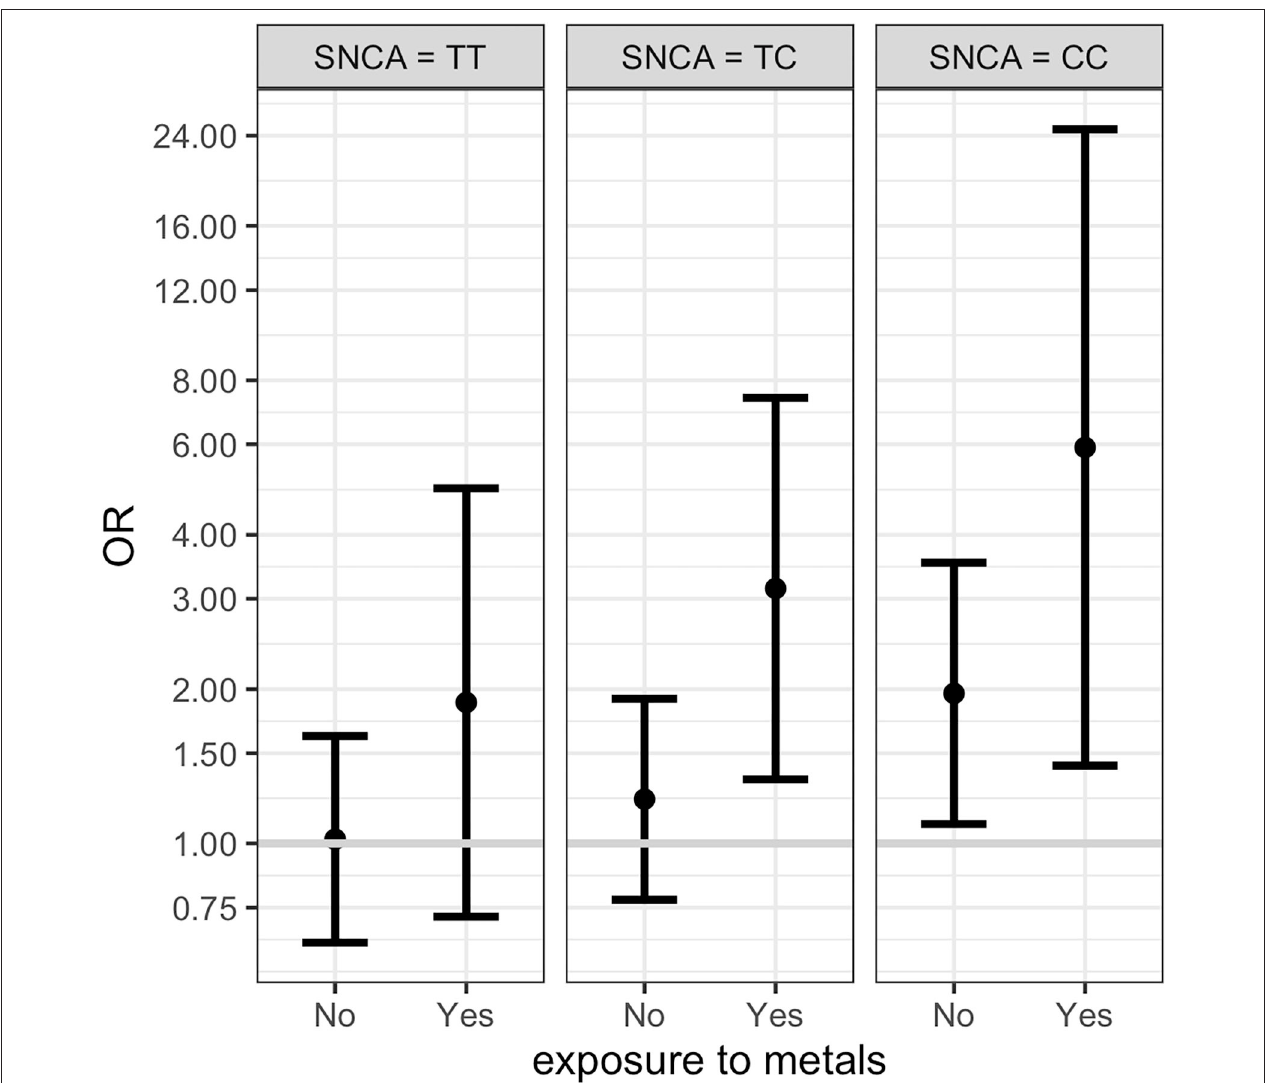
FIGURE 1 | Conditional ORs of having PD depending by SNCA rs356219 and metal exposure (fixing the other covariates values at reference value) estimated from the multinomial regression. The first plot represents the conditional OR for subjects with SNCA TT polymorphism non-exposed and exposed to metals. The second and third columns shows the conditional ORs for TC and CC polymorphisms respectively. 95% CI are represented by the